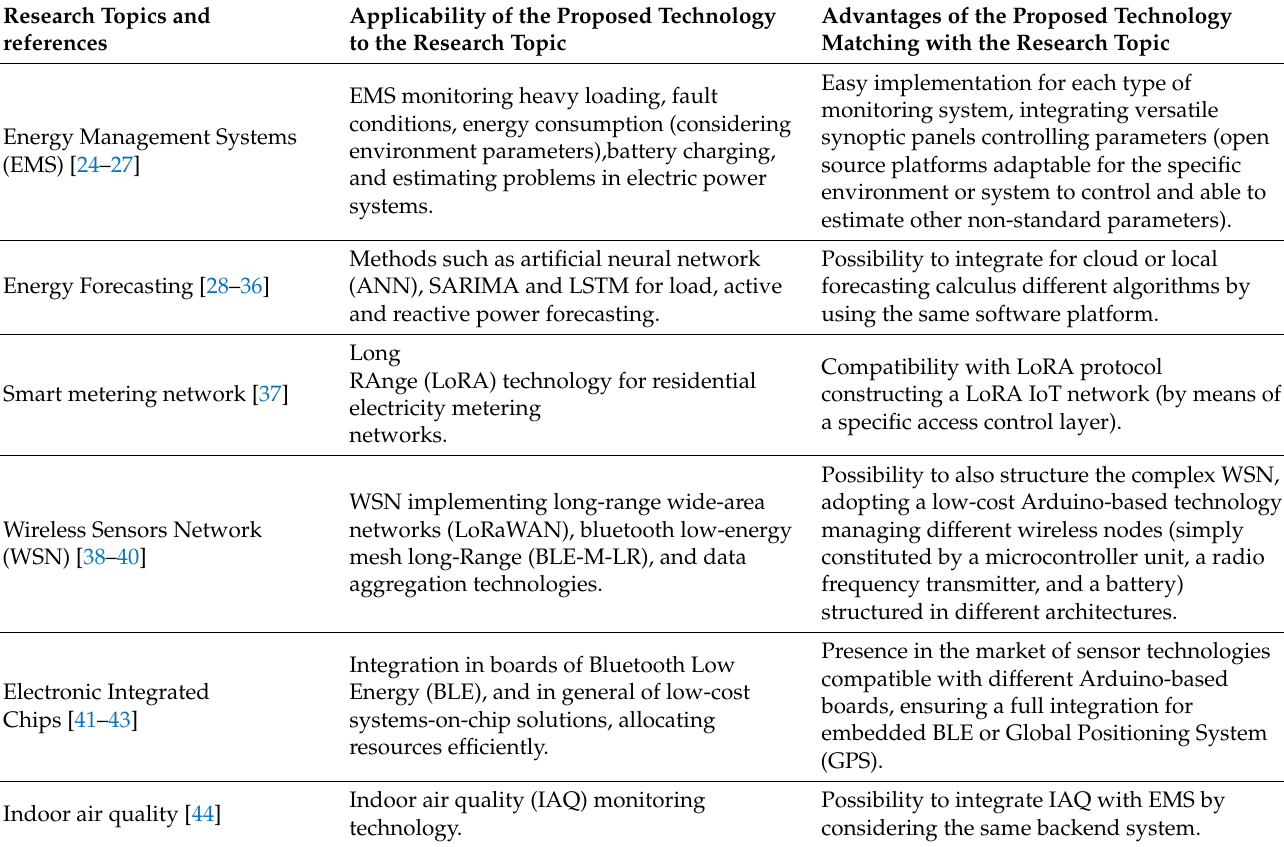
Table 3. Comparison with commercial